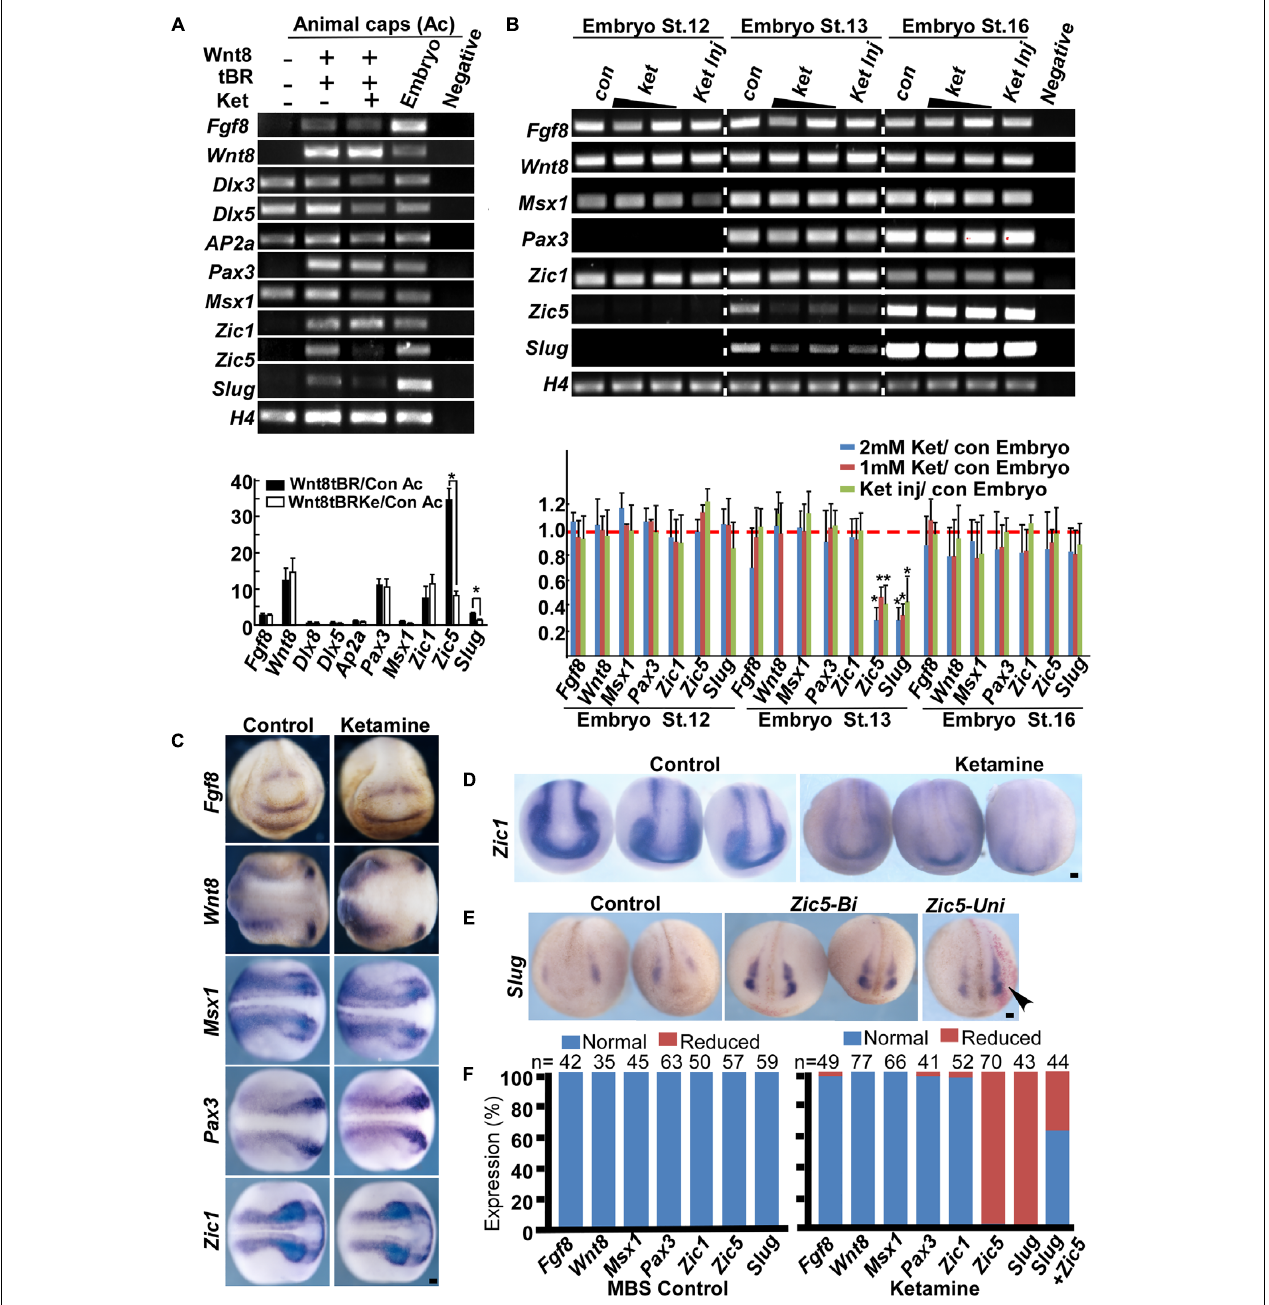
FIGURE 3 | Ketamine targets Zic5 in NC induction. (A) In animal caps, Wnt8 (500 pg) and tBR (500 pg) induce expression of NC markers (lanes 1, 2). Upon ketamine exposure, the expression of Zic5 and Slug were inhibited (lanes 2, 3). The induced expression of Zic5 and Slug were reduced by ketamine treatment in animal cap. Gene expressions were normalized with H4. Data are shown as folds over the control animal caps. 15 animal caps were isolated for each group for single time experiments. The number represents Mean ± SEM, N = 3, ∗ P < 0.05 by ANOVA. (B) In whole embryos, either ketamine exposure or injection (0.8 nmol/embryo) blocked Zic5 and Slug expression at stage 13 (when the NC is being induced) but not stage16 (at the onset of NC migration). Ketamine treatment did not affect most of the border genes from stage 12 to stage 16, but significantly blocked Zic5 and NC gene Slug at stage 13. For a single time experiment, 10 embryos were collected for each group for RT-PCR. Data are shown as folds over the control embryos. The number represents Mean ± SEM. N = 3, ∗ P < 0.05 by ANOVA. (C) In situ hybridization suggests genes involved in NC induction, including Fgf8 , Wnt8 , Msx1 , Pax3 , and Zic1 were not affected by ketamine exposure. (D) Ketamine inhibited Zic5 expression comparing with MBS cultured control group. (E) The inhibition of Slug expression by ketamine was rescued by injection of Zic5 mRNA (500 pg) in both sides or unilaterally. Arrowhead indicate the unilaterally injected side. (F) Quantitative analysis of in situ hybridization results, left: MBS control group, right: ketamine exposure group. ∗ P < 0.05 with t -test. Con, control; Ket, ketamine; Ket Inj, ketamine injection; St., stage; Zic5-Bi, zic5 bilateral injection; Zic5-Uni, zic5 unilateral injection. Scale bar: 100 µ